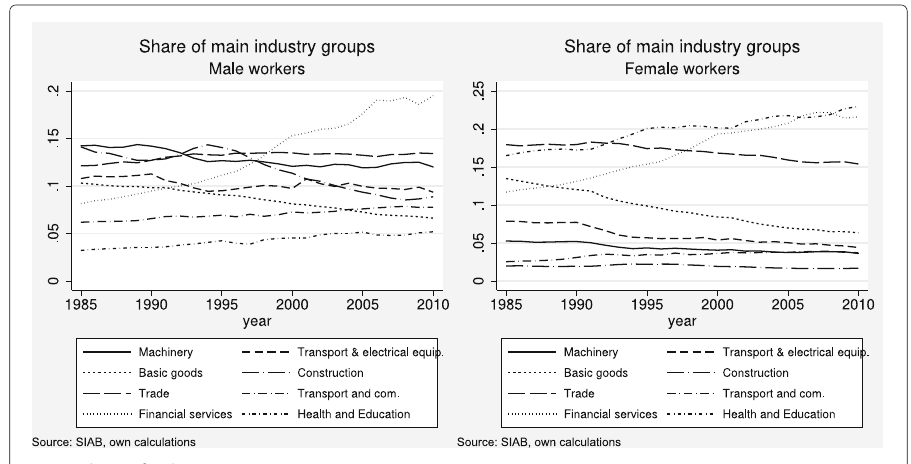
Fig. 9 Share of industry